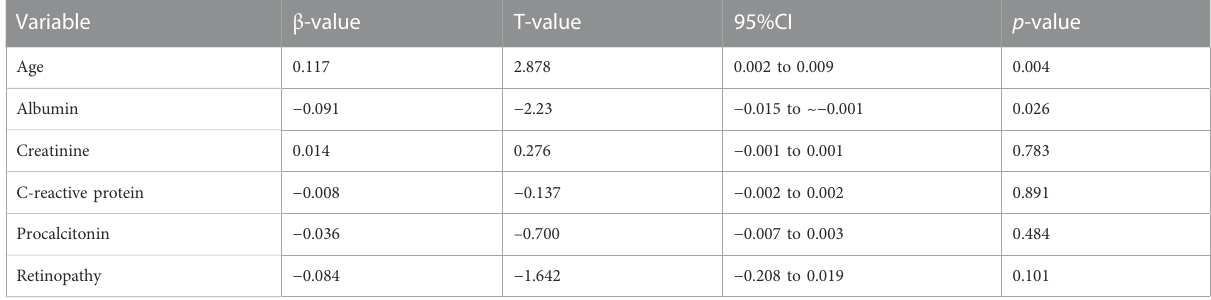
TABLE 4 Multivariate analysis of risk factors for DFU mortality. * p < 0.05, ** p < 0.01, and *** p <